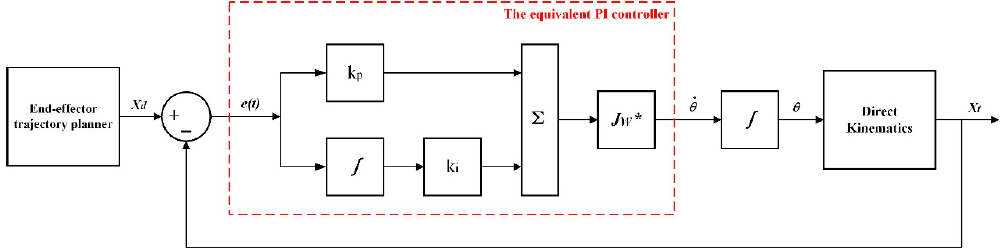
Figure 1. The block diagram of the path planning method that is equivalent to a PI controller.